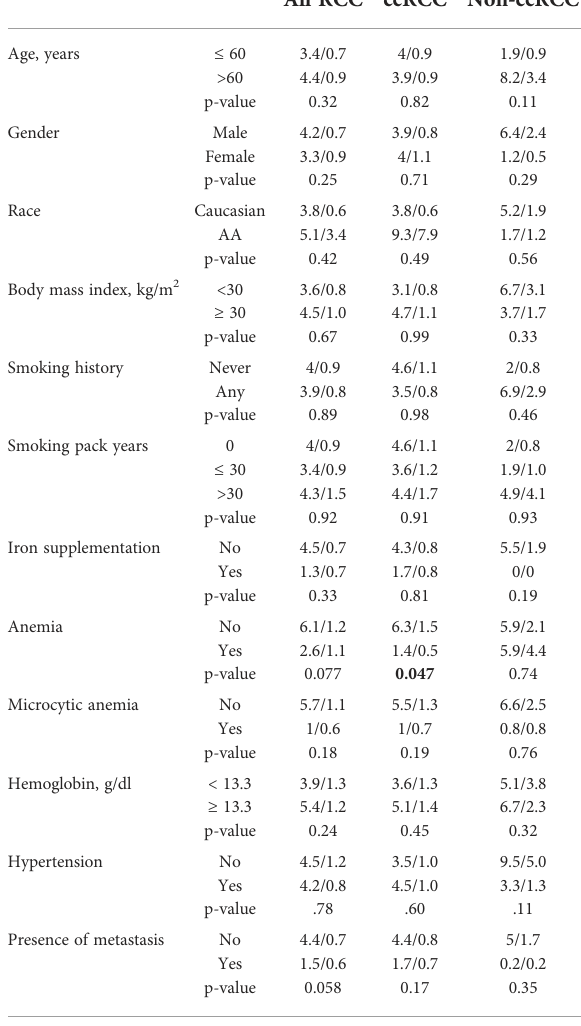
TABLE 4 Association between TME iron levels and RCC patient clinical features. TME Iron Level (Mean H-Score/ (Figure 5G; Table 2; Supplementary Figure 1C). In multivariable analyses adjusting for primary tumor pathology, renal epithelial iron levels in patients with ccRCC remained independently associated with metastasis-free survival (HR = 4.95, p = 0.004) but not cancer-speci fi c survival (HR = 1.71, p = 0.18) or overall survival (HR = 1.12, p = 0.76) (Table 2).